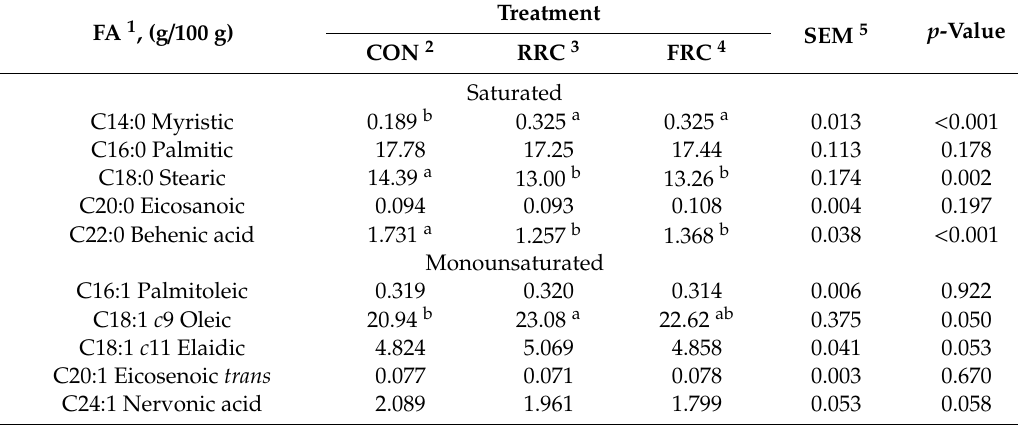
fatty acid profiles of breast muscle (g / 100 g FA; 14-day-old birds); experiment 2. FA 1 , (g / 100